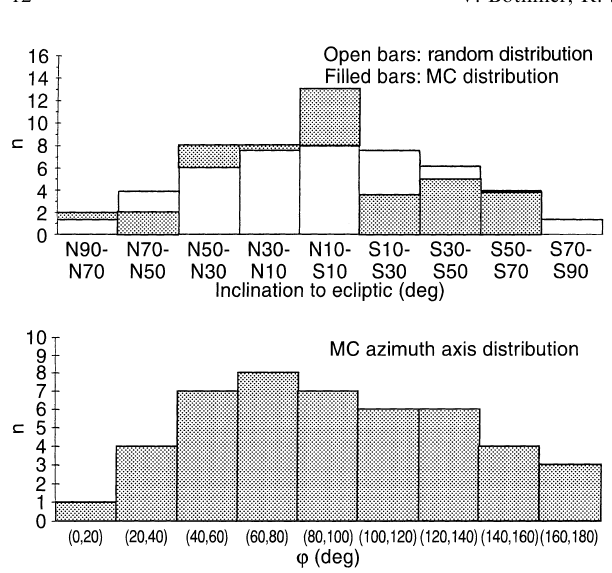
Fig. 9. Frequency distribution for the calculated axis orientations of all 46 MCs observed with Helios 1/2 between 0.3 and 1 AU. Top diagram : comparison of the distribution for the cloud’s axis inclinations relative to the ecliptic plane in 20 (cid:14) bins between 90 (cid:14) S–90 (cid:14) N with a random distribution. Solid bars represent the number of MCs in each bin, open bars represent the number of cases expected from the random distribution. Bottom diagram : distribution for the cloud’s axis azimuthal angles in the ecliptic in 20 (cid:14) bins between 0 (cid:14) –180 (cid:14)